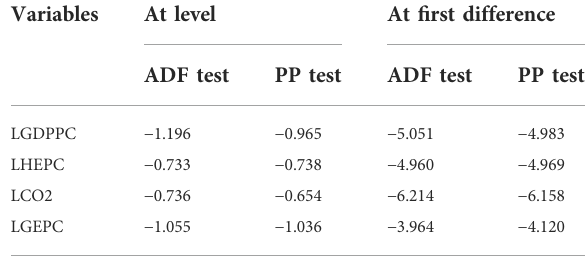
TABLE 2 ADF unit root tests.